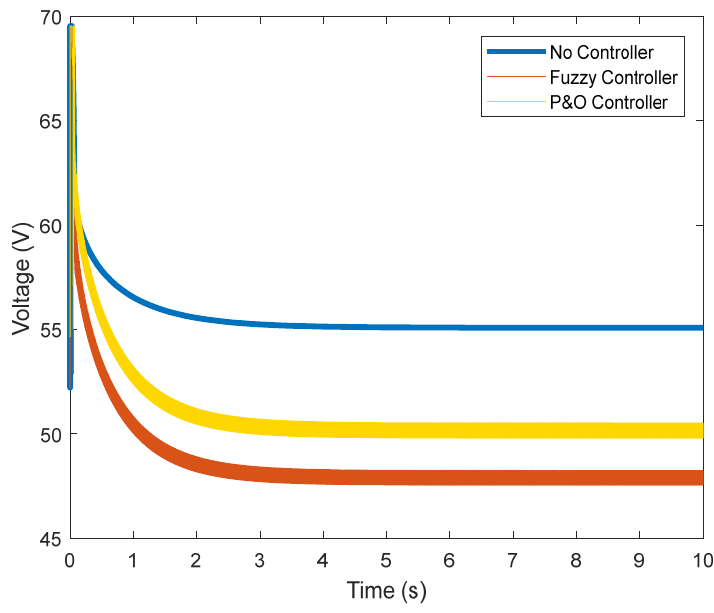
Figure 10. Output voltage of the fuel cell.